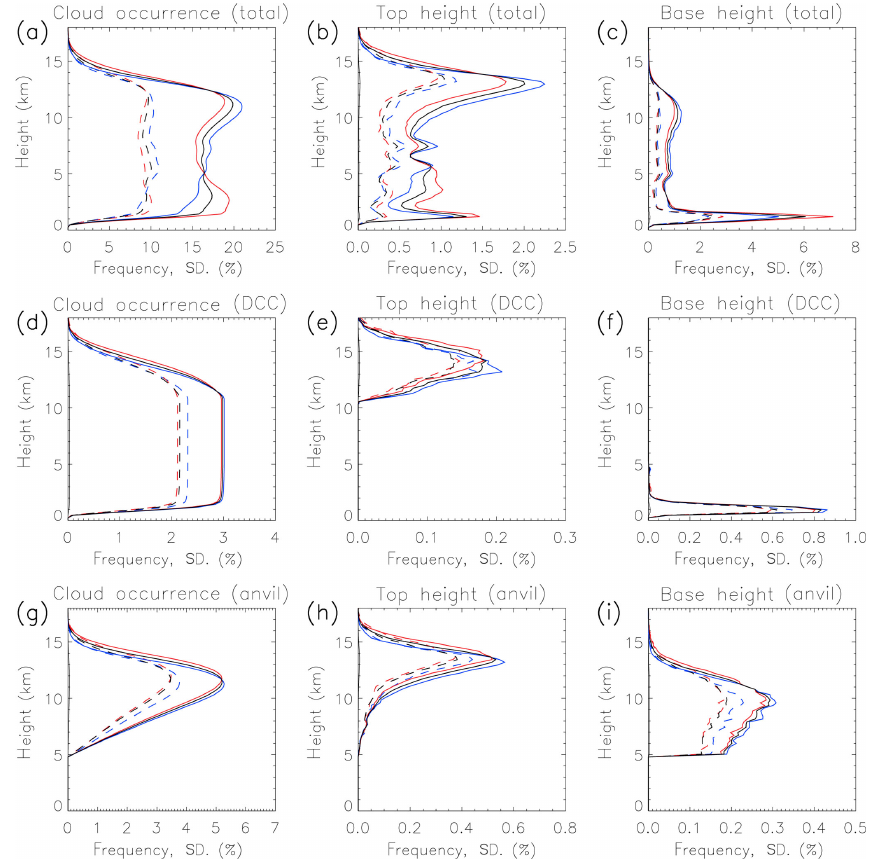
Figure 2. Top row: vertical frequency profiles of (a) cloud occurrence, (b) cloud top heights, and (c) cloud base heights. Black lines are for day/night, and red (blue) is for day-only (night-only). Solid (dashed) line is the mean (standard deviation). Middle row: same as the top row, but for (d) DCC-only occurrence, (e) top heights, and (f) base heights. Bottom row: same as the top row, but for (g) anvil-only occurrence, (h) top heights, and (i) base